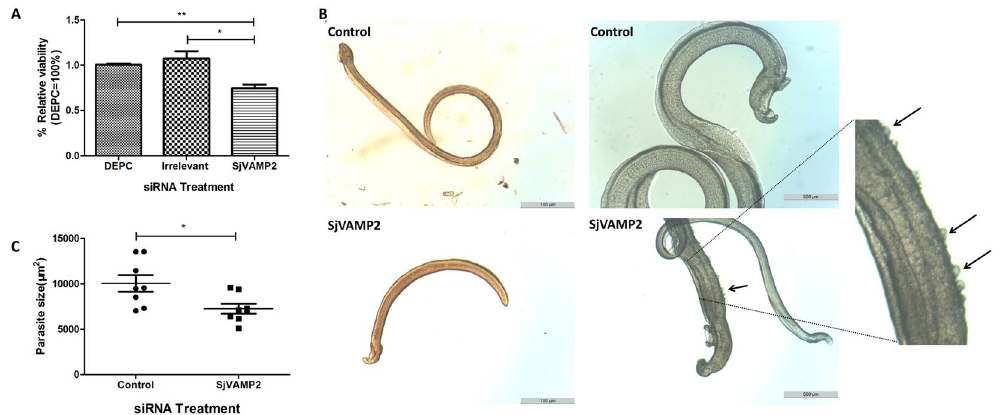
Figure 2. Relative viability and morphological changes of schistosomes treated with SjVAMP2 specific siRNA. ( A ) The viability of worms was compared to DEPC control group from three independent experiments. ( B ) The morphological changes of worms were captured via optical microscopy. Images were derived from 3 randomly selected male worms from each group. Arrows indicated bulb-like structures on the surface of some male schistosomes. ( C ) The size of male schistosomes was analyzed by imageJ. Data was compared with DEPC control ( * P < 0.05, ** P <